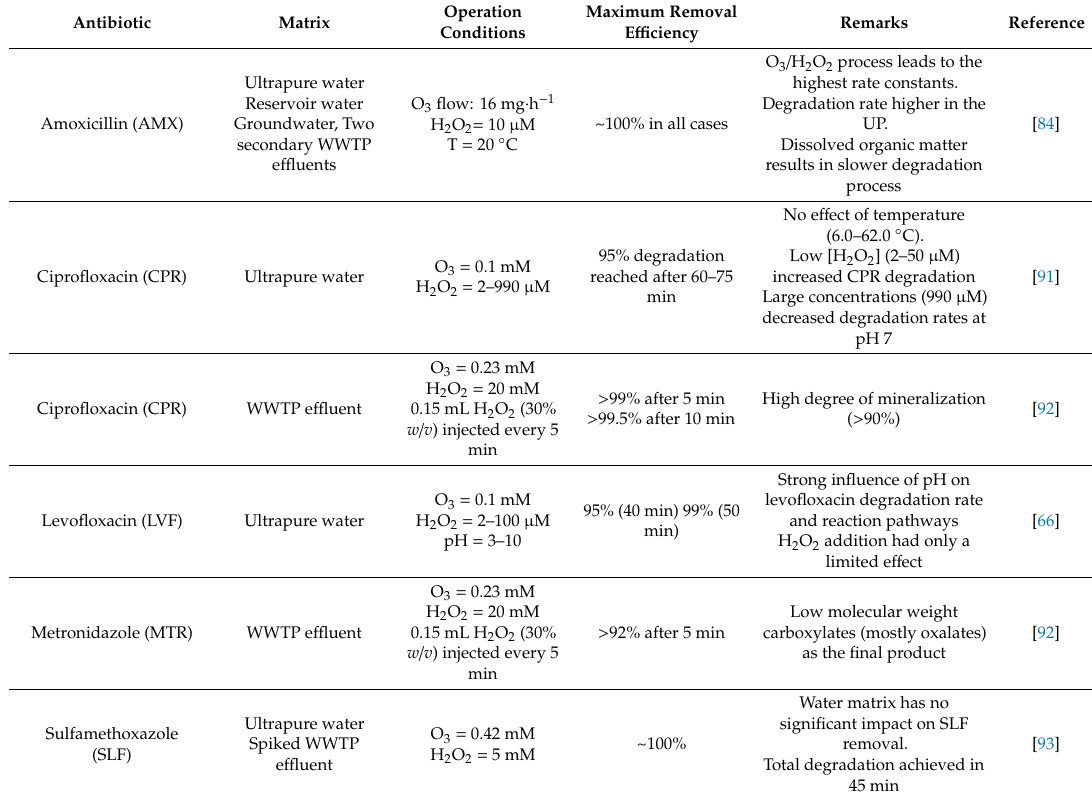
Table 7. Removal e ffi ciency of antibiotics in waters by the O 3 / H 2 O 2 process.